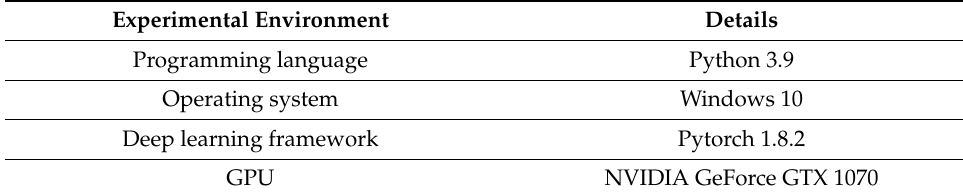
Table 3. The experimental conditions.